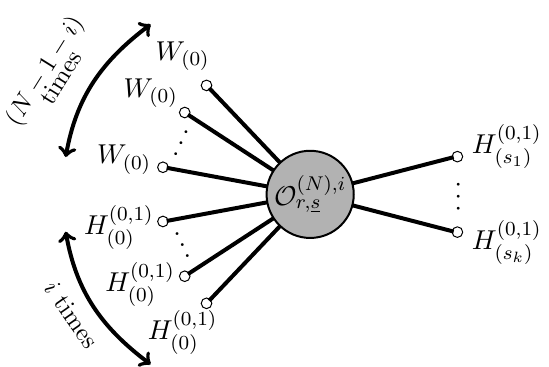
as ( N (cid:0) 1 (cid:0) i ) W and i H (0 ; 1) coupling to multiple (0) ( s ) (0)